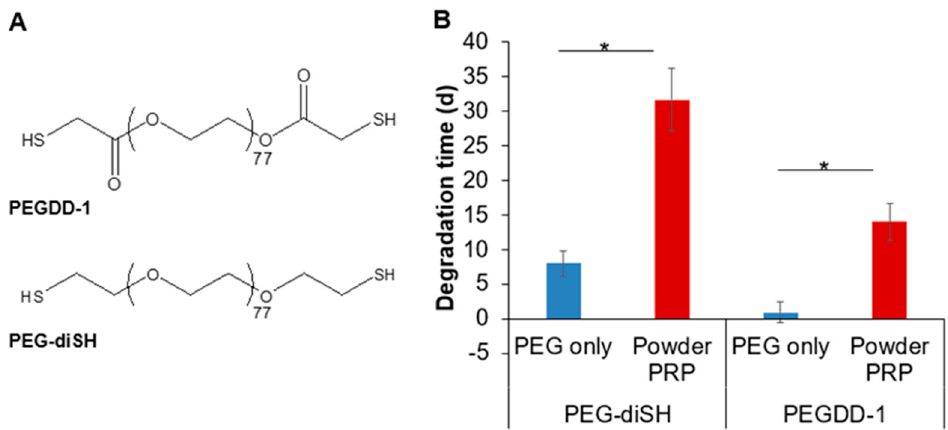
Figure 8. Degradation of PEG-only and PRP-loaded PEG microspheres in PBS as a function of the crosslinker used for microsphere preparation. ( A ) Chemical structures of PEGDD-1 and PEG–diSH. ( B ) Microsphere degradation time. Microspheres were prepared with 4-arm PEG–Ac and PEG–diSH or PEGDD-1 as a crosslinker at 7.5% w/v in PEG. Powder PRP was loaded at 10% w/v. * denotes significant difference between groups (n = 50; p < 0.05).